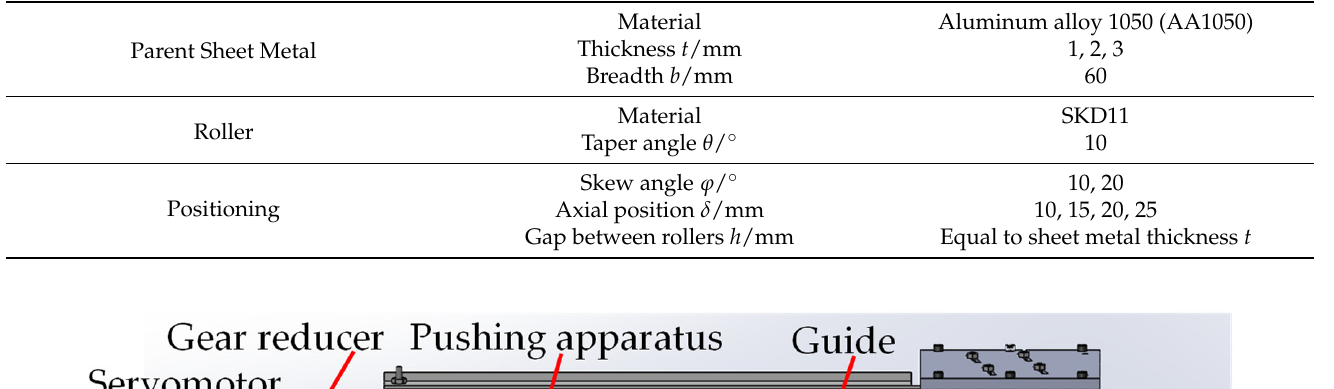
Figure 3. Dimensions of the roller. Table 1. Experiment conditions.